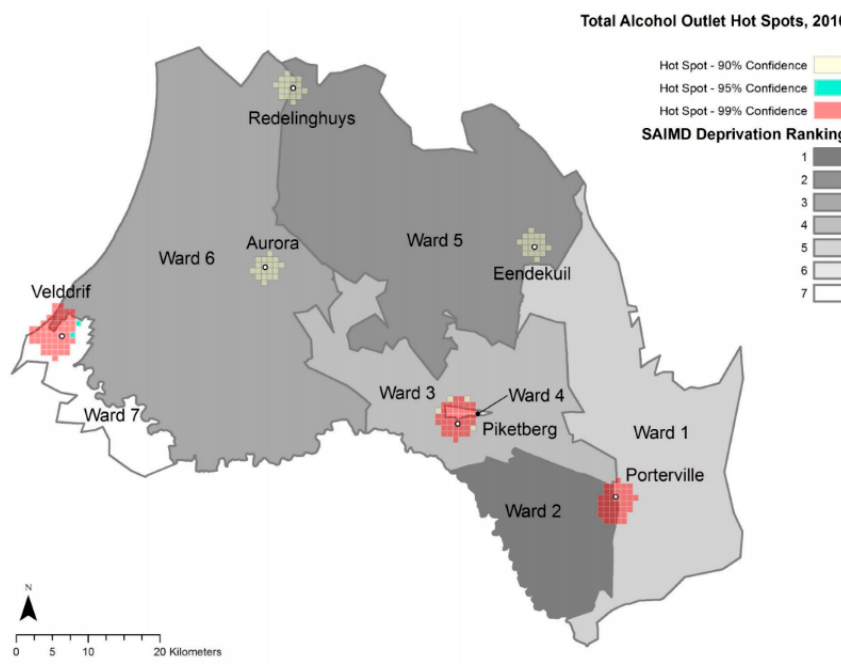
Figure 2. Total Alcohol Outlet Hot Spots, 2016 and Ward Deprivation.